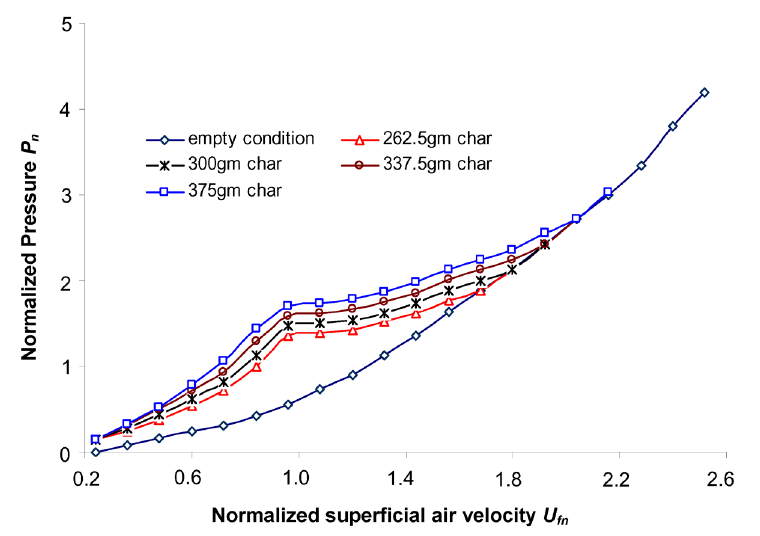
Fig. 5: Pressure difference on lower side of the distributor plate, P superficial air velocity, U